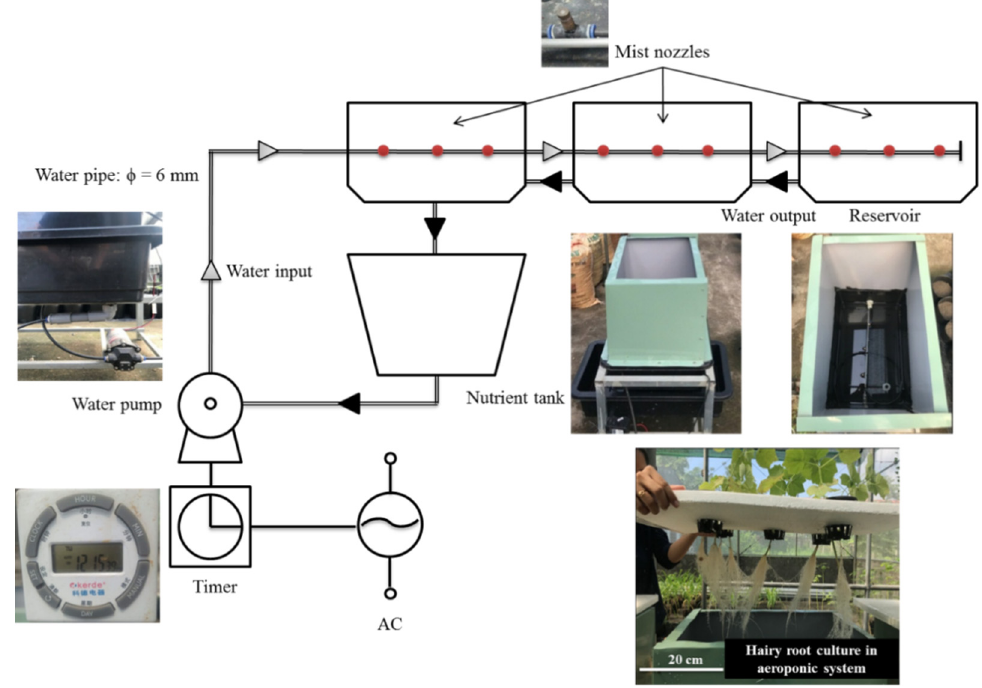
Figure 9. Aeroponics system. φ : diameter, AC: alternating current